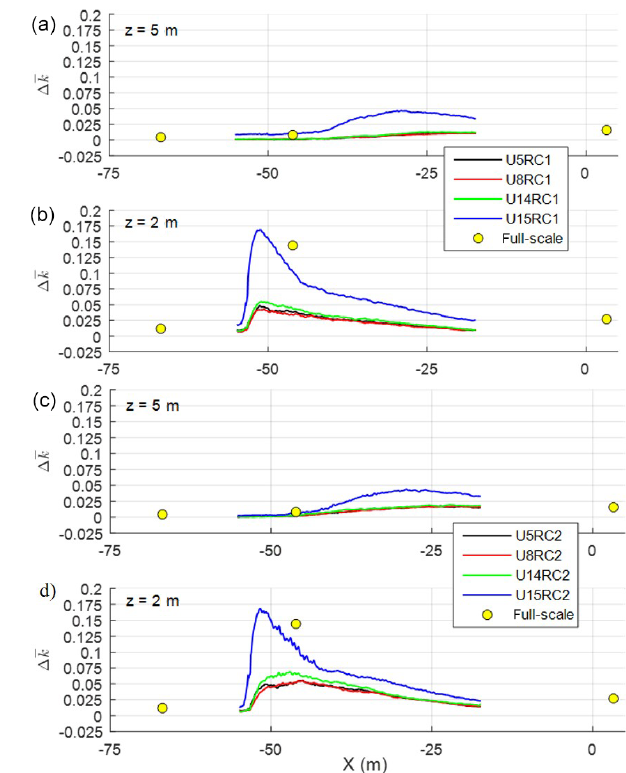
Figure 17. Horizontal profiles of TKE increment (cid:49)k for (a) RC1 cases at z = 5m, (b) RC1 cases at z = 2m, (c) RC2 cases at z = 5m, and (d) RC2 cases at z = 2m. Figure 18.